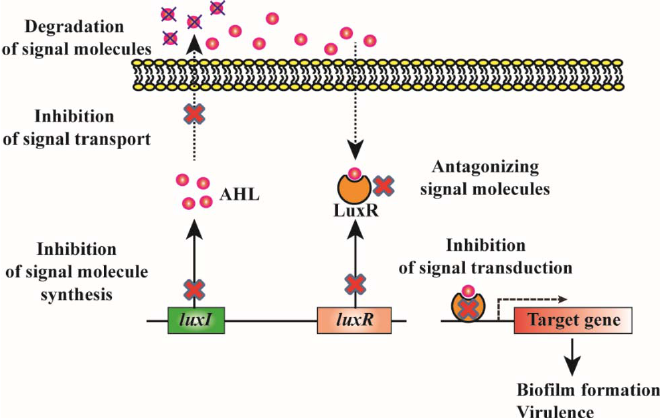
Figure 1. Schematic representation of various quorum-quenching strategies to control biofilm formation. LuxI and luxR genes encode AHL signal synthase and AHL receptor/activator protein respectively. AHL signal synthase is responsible for the production of AHLs, which are diffused (short chain) or pumped (long chain) out of the bacterial cell to the surrounding medium before being taken up into the nearby bacterial cells. The AHL binds to the receptor protein and the AHL-receptor complex activates the expression of quorum-sensing target genes. The quorum-quenching strategies that have been used for attenuating AHL-mediated phenotypes include the inhibition of AHL synthesis, inhibition of signal transport, degradation of signal molecules, inhibition of AHL receptor synthesis, inhibition of AHL-receptor complex formation, inhibition of the binding of AHL-receptor complex to the promoters of target genes